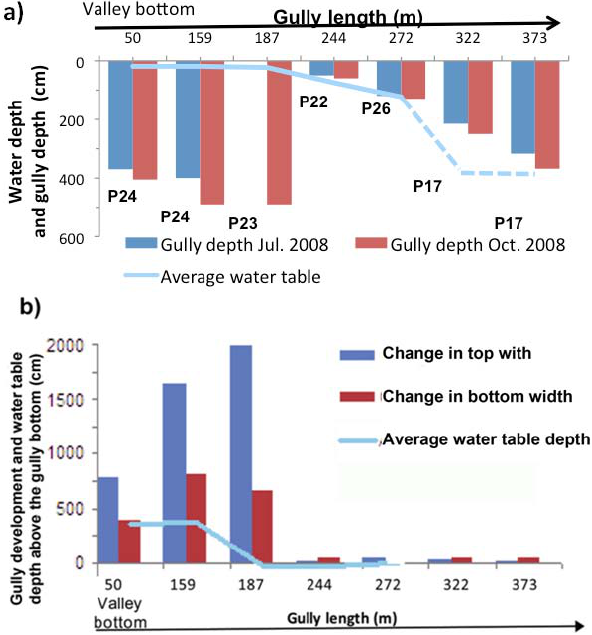
Fig. 5. (a) Average water table depth and gully depths before and after the 2008 rainy season for the main stem (gully C) using the soil surface as a reference elevation point. Note that piezometers p17 and p24 were adjacent to two gully cross-sections and (b) change in top and bottom width of the gully and average water table depth above the gully